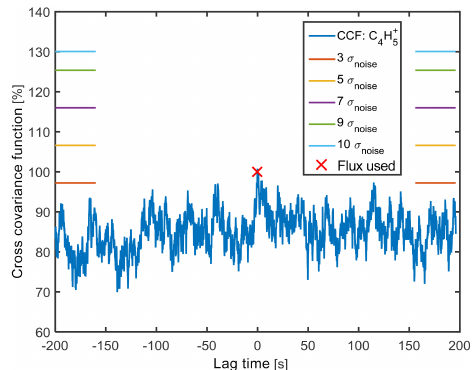
Figure A8. Averaged absolute CCF of C 4 H + 3 σ noise criteria.